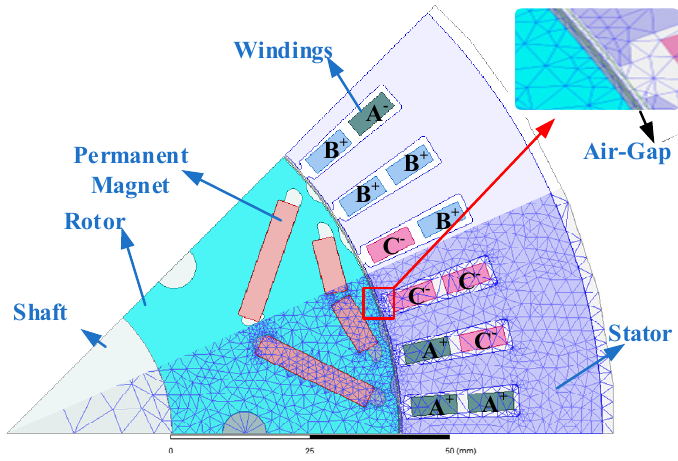
Figure 2. Schematic of the 48-slot, 8-pole PMSM prototype (1/8 of the model). Table 1. Design parameters of the machine prototype.